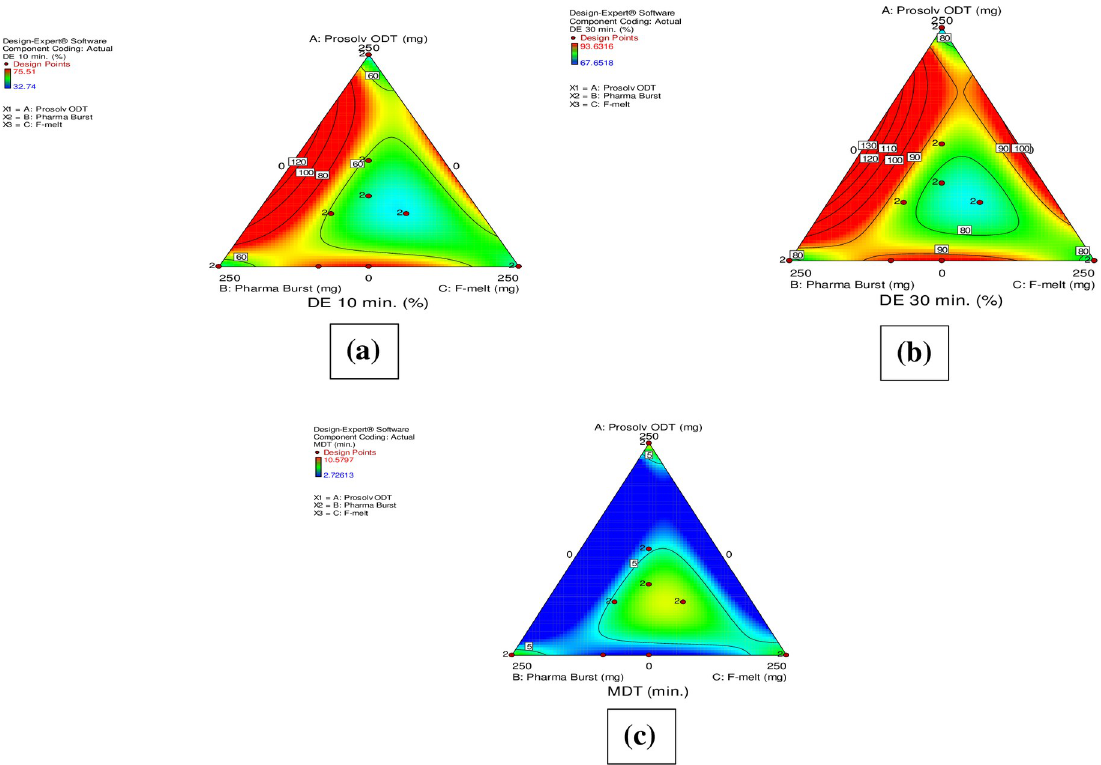
Fig 2. Contour plots of the effect of formulation variables on DE (10 min) % (Y 1 ) (a), DE (30 min) % (Y 2 ) (b) and MDT (Y 3 ) (c) on DCN-ODTs. https://doi.org/10.1371/journal.pone.0244646.g002 Also, positive effect of each of X , X and X on Y is observed by their presence alone and 1 2 3 3 in triple combination only. Results showed that formulations with high dissolution efficiency percent attained lower MDT values and vice versa. F1 (composed of equal concentrations of the three co-processed excipients) exhibited the least DE % (32.74%), DE % (10 min) (30 min) (67.65%) and the longest MDT (10.58 min) among the prepared formulations. These results cohere well with the polynomial equations for the three responses (Table 3). It is clear that ter- nary mixture of co-processed excipients produced a synergistic effect upon responses under study. On the other hand, F10 attained the highest DE % (75.51%), DE % (10 min) (30 min) (93.63%) and the least MDT (2.72 min). F10 contains a high concentration of Pharmaburst 1 500 which contains crospovidone; a superdisintegrant. This enables rapid absorption of fluids